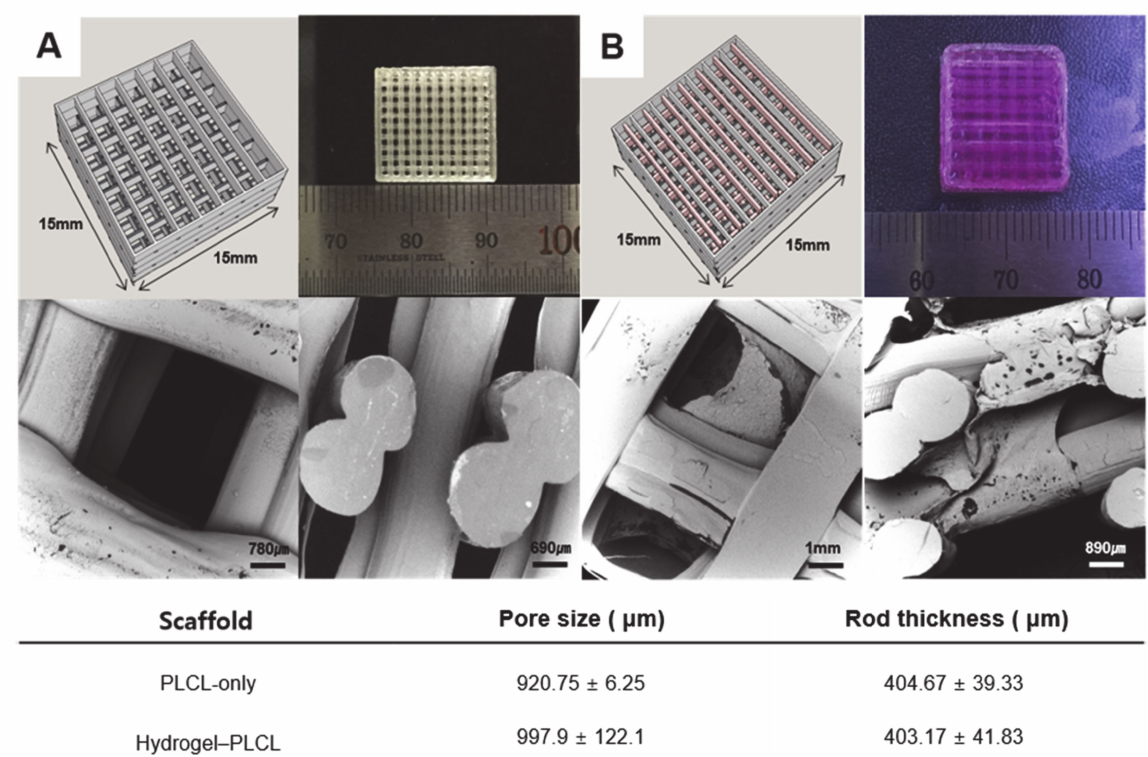
Figure 5. 3D-printed scaffold. Standard Triangle Language (STL) file image for 3D printing, macroscopic image, and SEM images of the ( A ) PLCL-only scaffold and ( B ) Hydrogel–PLCL complex construct. The pore size and rod thickness were